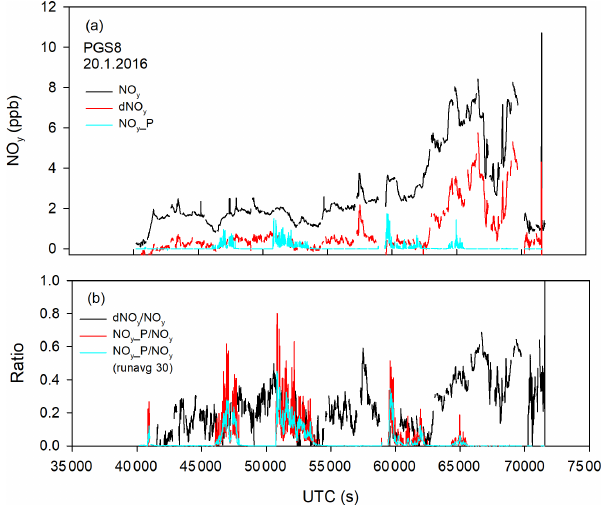
Figure 14. NO y partitioning for PGS flight 8. Gas-phase NO y , dNO y = NO y − NO ∗ y (calculated) and enhancement corrected par- ticulate nitrate are shown. (a) Absolute values; (b) dNO y / NO y ratio, NO y _P / NO y ratio, with 1s values and as running average